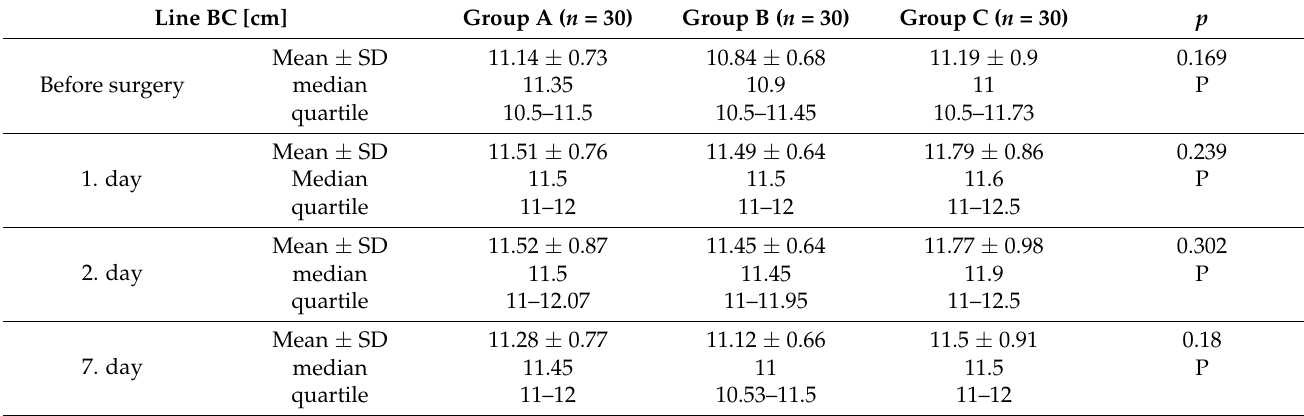
Table 6. Results of comparative analysis of BC line length before treatment and on day 1, 2, and 7 after treatment between groups A, B, C.